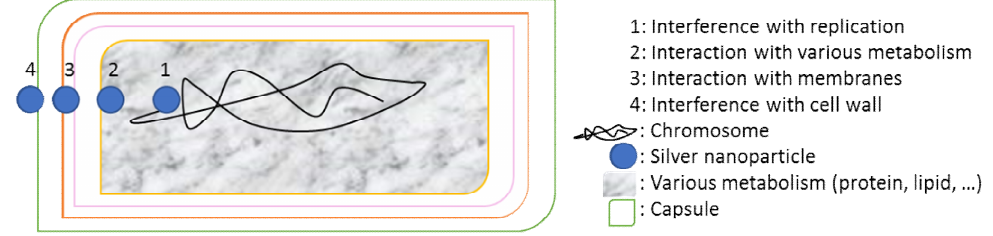
Figure 2. Schematic representation of the bacterial inactivation mechanisms using silver